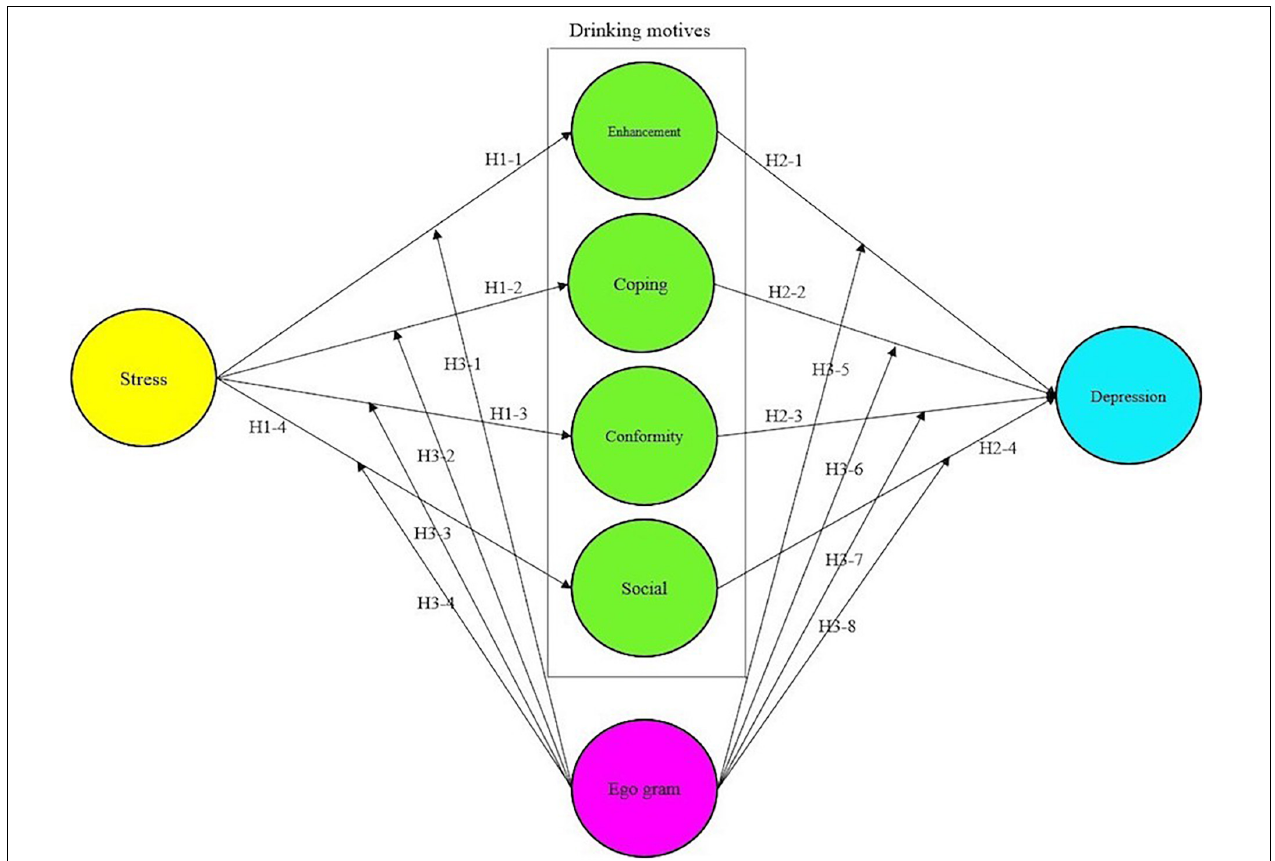
FIGURE 1 | Diagram of the research model.